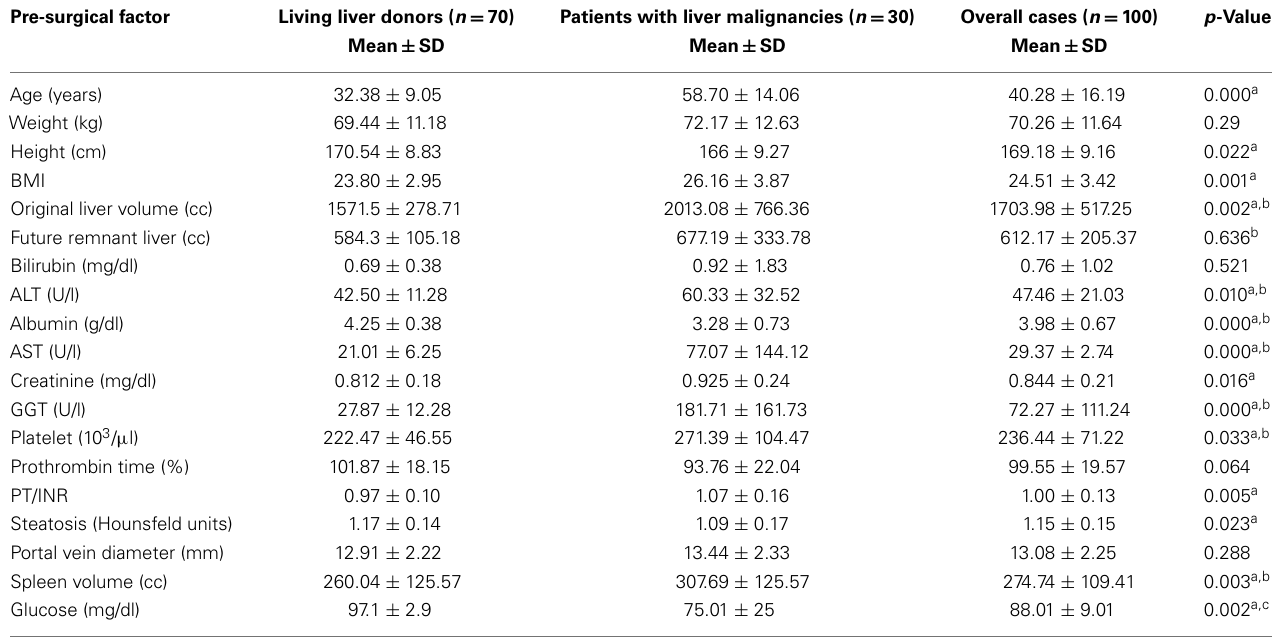
Table 1 | Demographic characteristics for all patients and comparison of pre-surgical factors between patient types: living liver donors and patients with liver